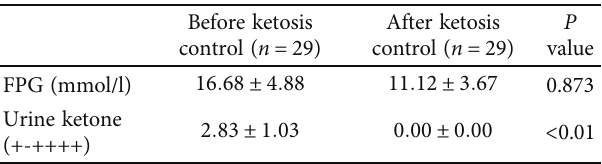
FPG: fasting plasma glucose. Data are expressed as mean ± SD